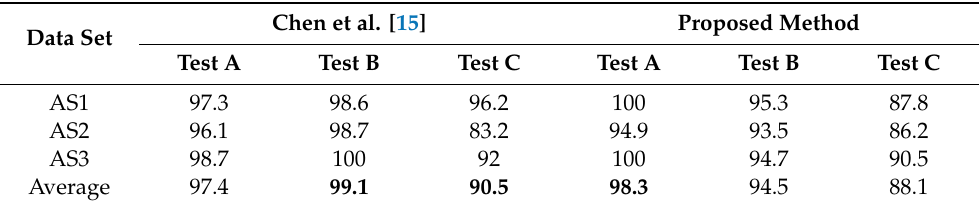
Table 6. Comparison of the recognition rates for the MSR-Action 3D dataset. Chen et al. [15] Data Set